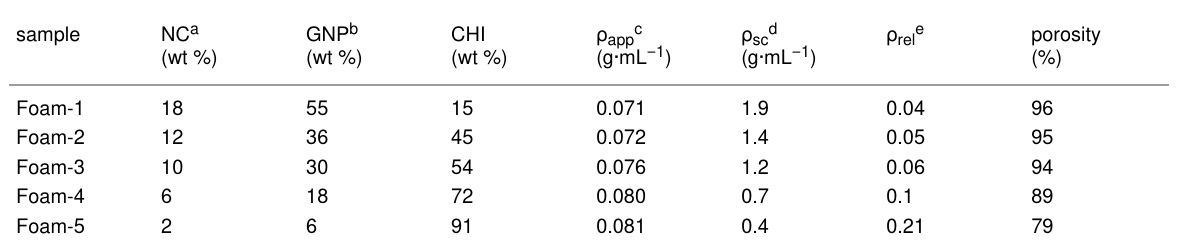
Table 1: Apparent, skeletal, and relative density together with the corresponding porosity of the bionanocomposite foams.